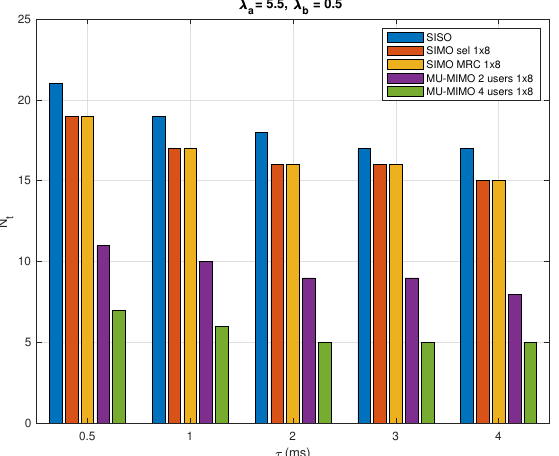
Figure 10. Total number of required RRs in a typical cell with respect to maximal access delay τ max with λ a = 5.5 nodes/km 2 and λ b = 0.5 nodes/km 2